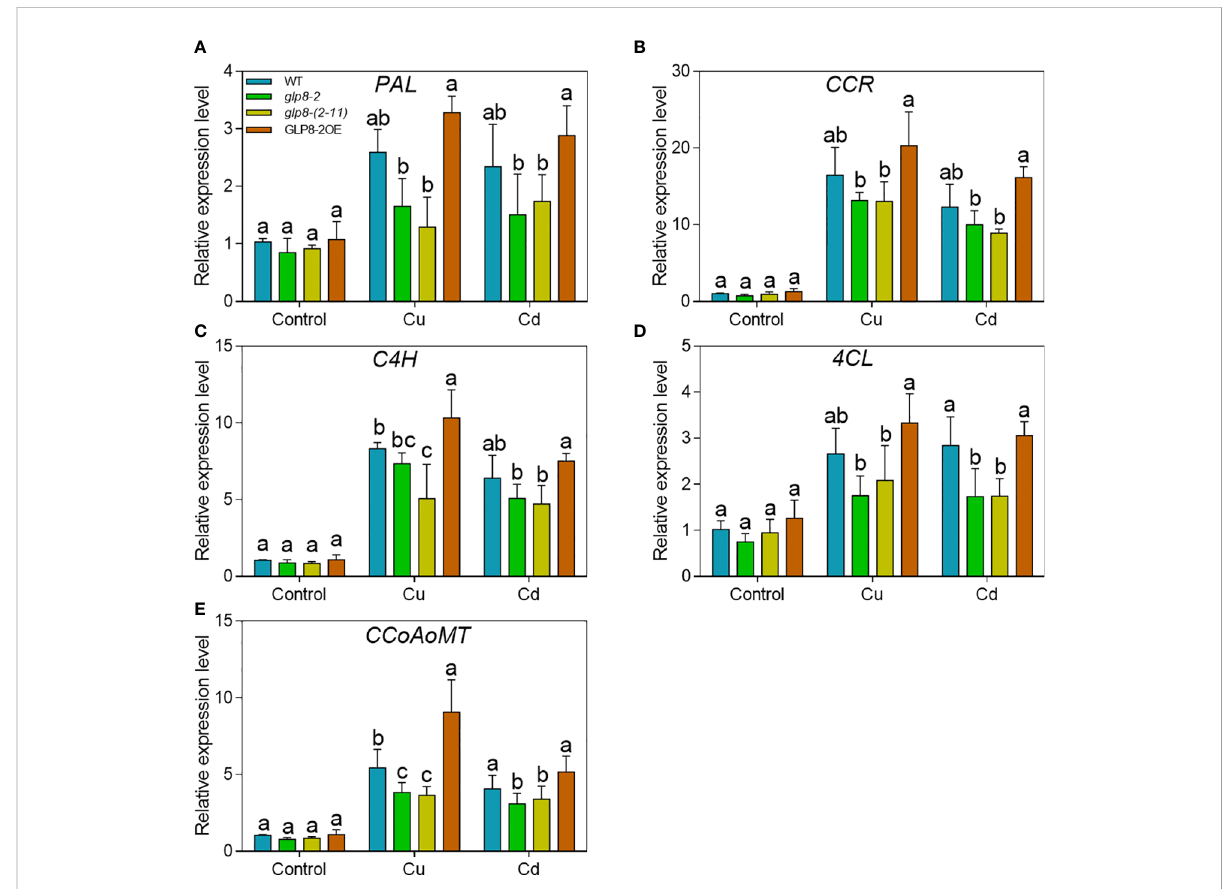
FIGURE 6 OsGLPs upregulate the expression of lignin synthesis-related genes using RT-qPCR. The expression of PAL (A) , CCR (B) , C4H (C) , 4CL (D) , and CCoAoMT (E) in 2-week-old WT (wild type) and transgenic seedlings grown for 5 days under normal conditions, 10 m mol L − 1 CuSO 4 treatment, or 25 m mol L − 1 CdCl 2 treatment. ACTIN1 (LOC_Os03g50885) was used as the internal control. The relative expression level was obtained by normalisation to the expression level in WT plants without heavy metal treatment. Values are the mean ± SD; n = 3. Different letters indicate a difference of p ≤ 0.05 by the LSD